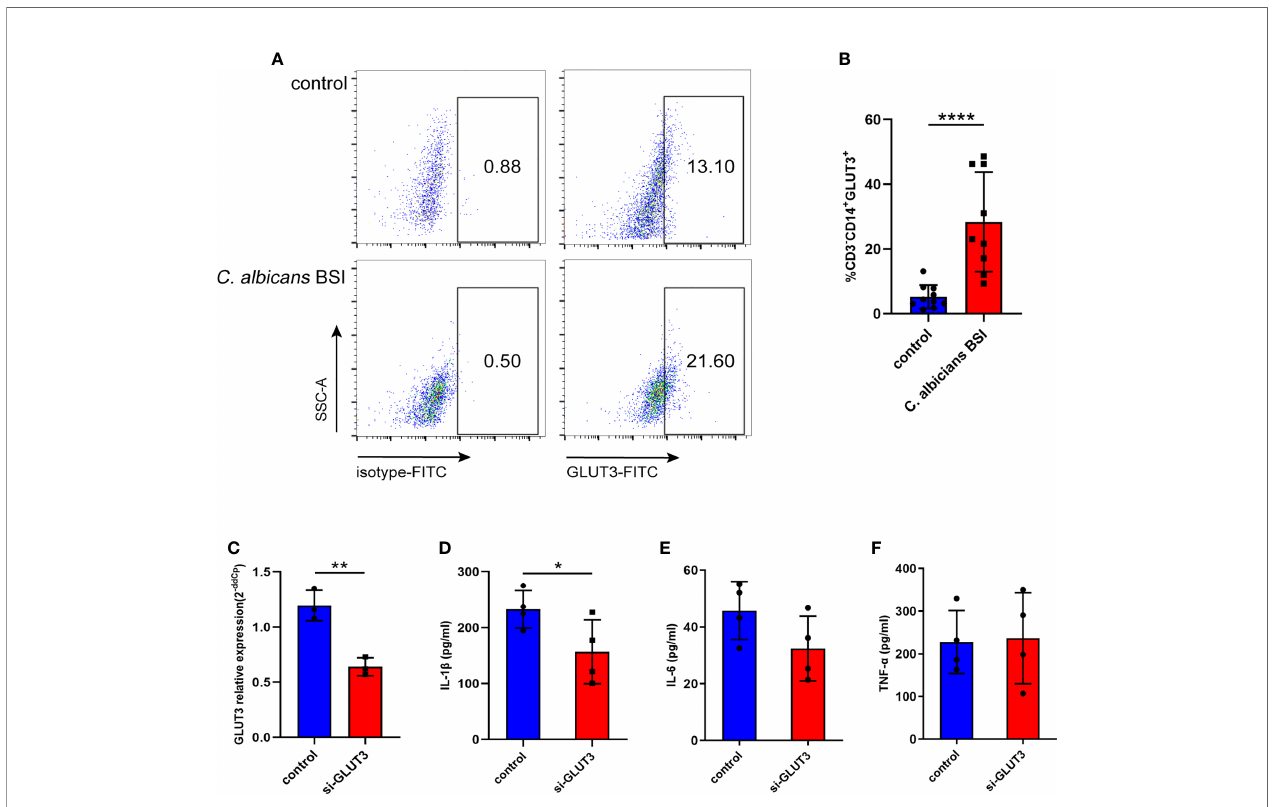
FIGURE 5 | The GLUT3-expression in patients with C. albicans BSI was preliminarily con fi rmed in monocytes. PBMCs were isolated from patients (n = 9) and healthy controls (n = 10), and then CD3 - CD14 + GLUT3 + monocytes were separated by fl ow cytometer and compared using the non-parametric Mann-Whitney test ( P < 0.0001). Representative fl ow cytometry dot plot (A) and summary data are shown (B) . GLUT3 knockdown by siRNA signi fi cantly reduced production of IL-1 b in the THP-1 cells. (C) The GLUT3 mRNA expression achieved by transfection of si-GLUT3 or negative control to THP-1 cells (n = 3). (D – F) Comparison of the secretion of IL-1 b , IL-6, and TNF- a in THP-1 cells stimulated by C. albicans for 24 h (n = 4). **** P < 0.0001; ** P < 0.01; * P <